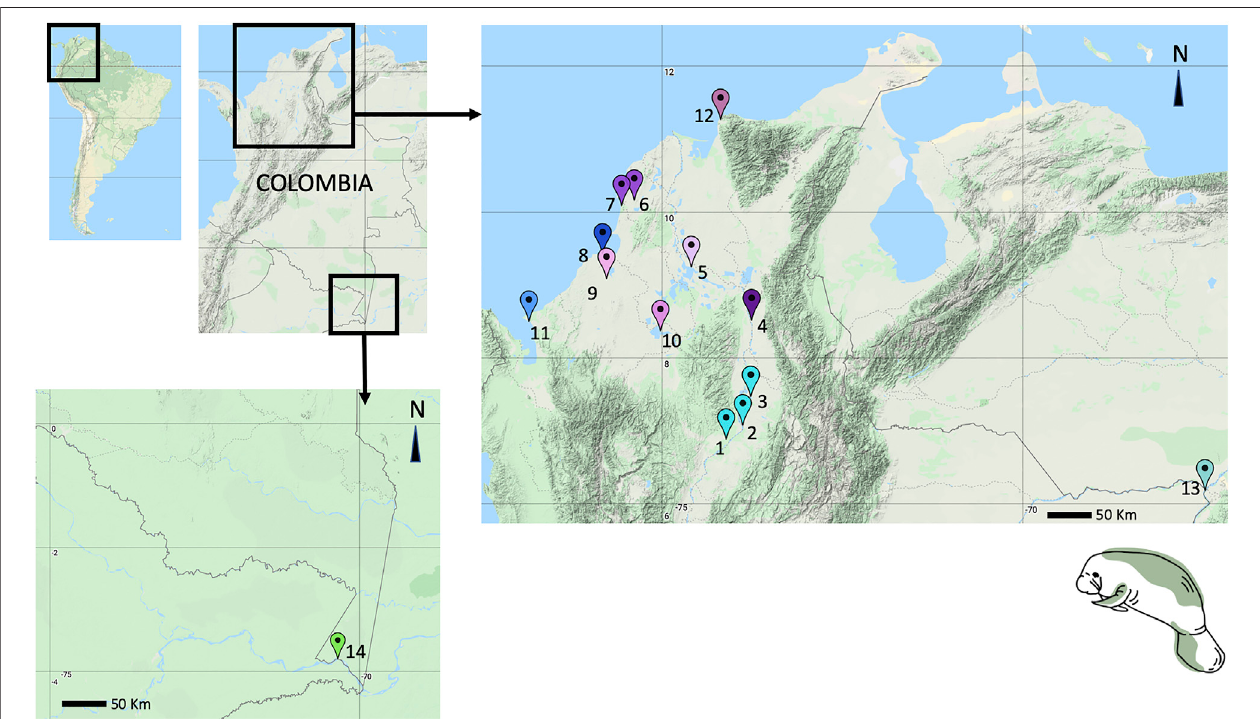
FIGURE 1 | Antillean and Amazonian manatee tissue sampling sites (new to this study): 1. Totumo Marsh, Yondo, Antioquia, 2. San Silvestre Marsh, 3. Paredes Marsh, 4. Aguachica, Cesar, 5. Magangue, 6. Canal del Dique, 7. EL Corchal, Bolivar, 8. Cispatá Bay, 9. Lorica Marsh, 10. Ayapel Marsh, 11. Necocli, Urabá Gulf, Antioquia, 12. Santa Marta, Magdalena, 13. Meta River, 14. Puerto Nariño, Amazonas. Colors in the map refer to colors in the haplotype networks.